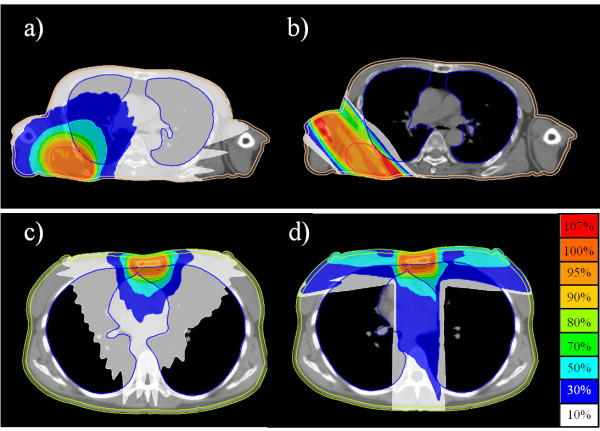
Thoracic wall target volume. Upper panel; the target volume located on the lateral wall was treated with TomoHelical mode (a) and TomoDirect mode (b). Lower panel; the target volume located near the midline was treated with TomoHelical mode (c) and TomoDirect mode (d).